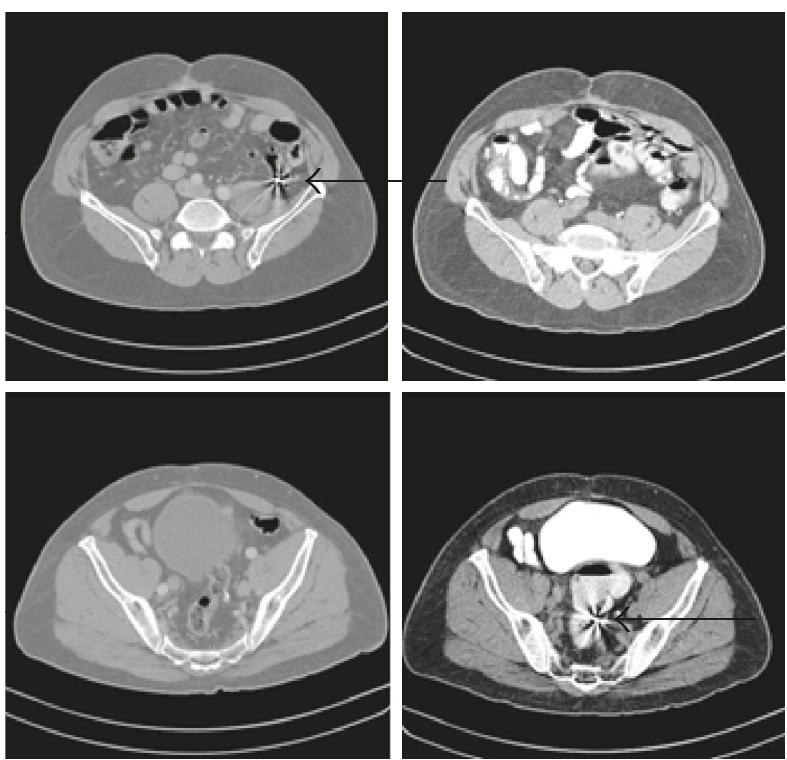
Figure 2: Abdominal computed tomography (CT) shows bullet fragments in the endoluminal descending colon (top arrow). Bullet migration located in the descending colon upon initial CT scan is now located in the rectal ampulla (bottom